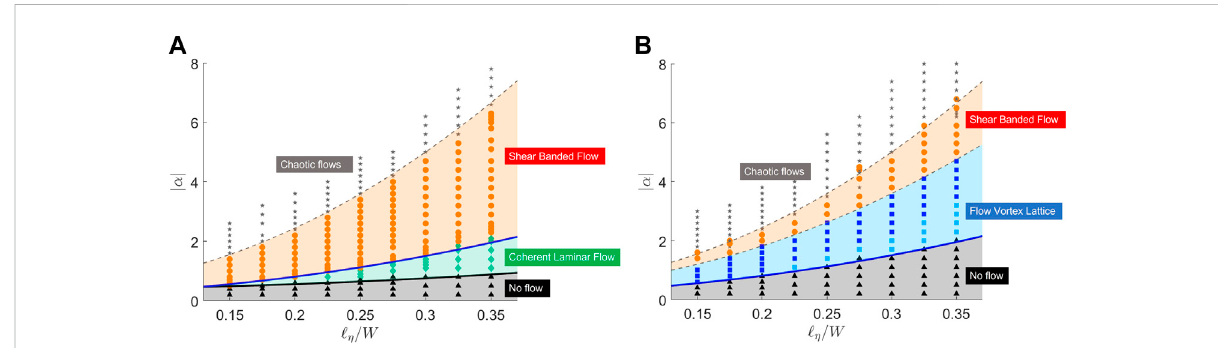
FIGURE 3 Thesephasediagramsshowthevarioussteady fl owstatesinthechannelaswechangethescreeninglengthandtheactivityata fi xedanchoring strength. The dashedlines are fi tsto theobservedphase boundaries whereas thesolid linescorrespond to thecurves calculated using linear stability analysisinSection4,withno fi ttingparameters.Thesolidbluelineinbothphasediagramscorrespondstothe mixed bend-splayinstability α m andthe solidblacklinein (B) correspondstothe splay instabilitywithweakanchoring, α s , w (Eq.16). (A) WeakAnchoring, ℓ κ /W=100. (B) StrongAnchoring, ℓ κ /W